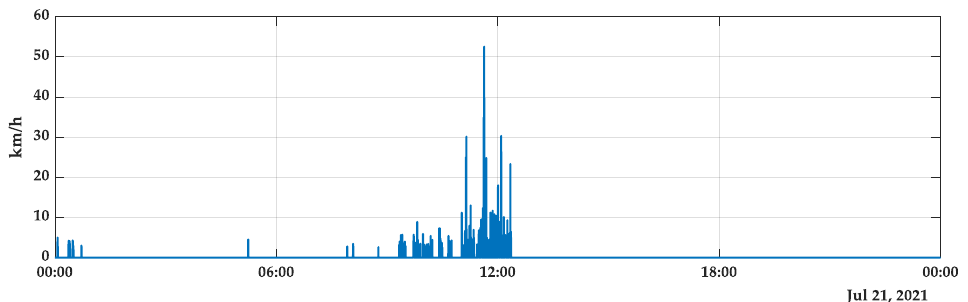
Figure 37. Records of light intensity.